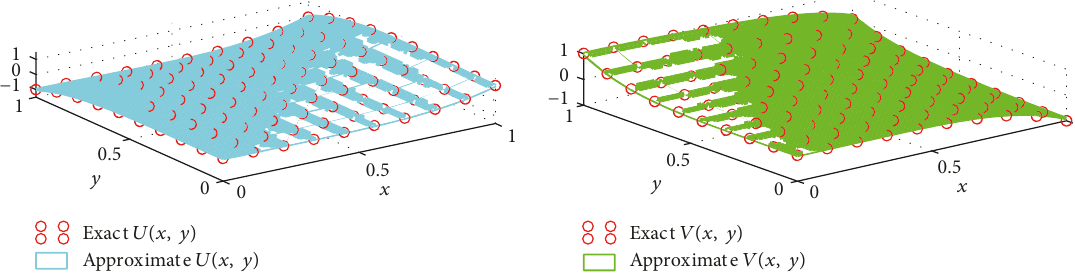
Figure 5: Evaluation between exact and approximate solutions 𝑈(𝑥, 𝑦),𝑉(𝑥,𝑦) for scale level 𝐾 = 8 of test Problem 3.